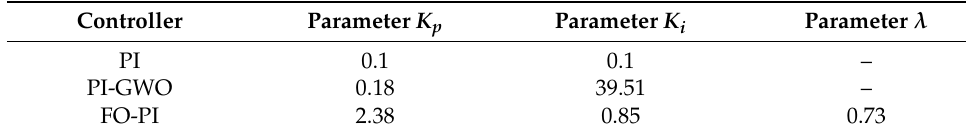
Table 1. Tuned parameters of PI, PI-GWO, and FO-PI